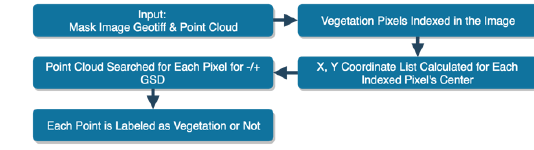
Figure 6. The process for the projection of vegetation mask to the